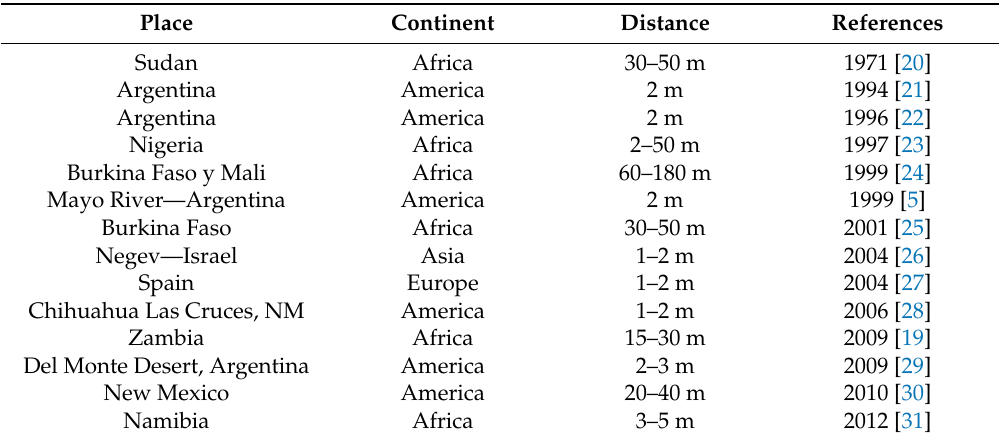
Table 1. Presence of the Leopard pattern in bibliographic